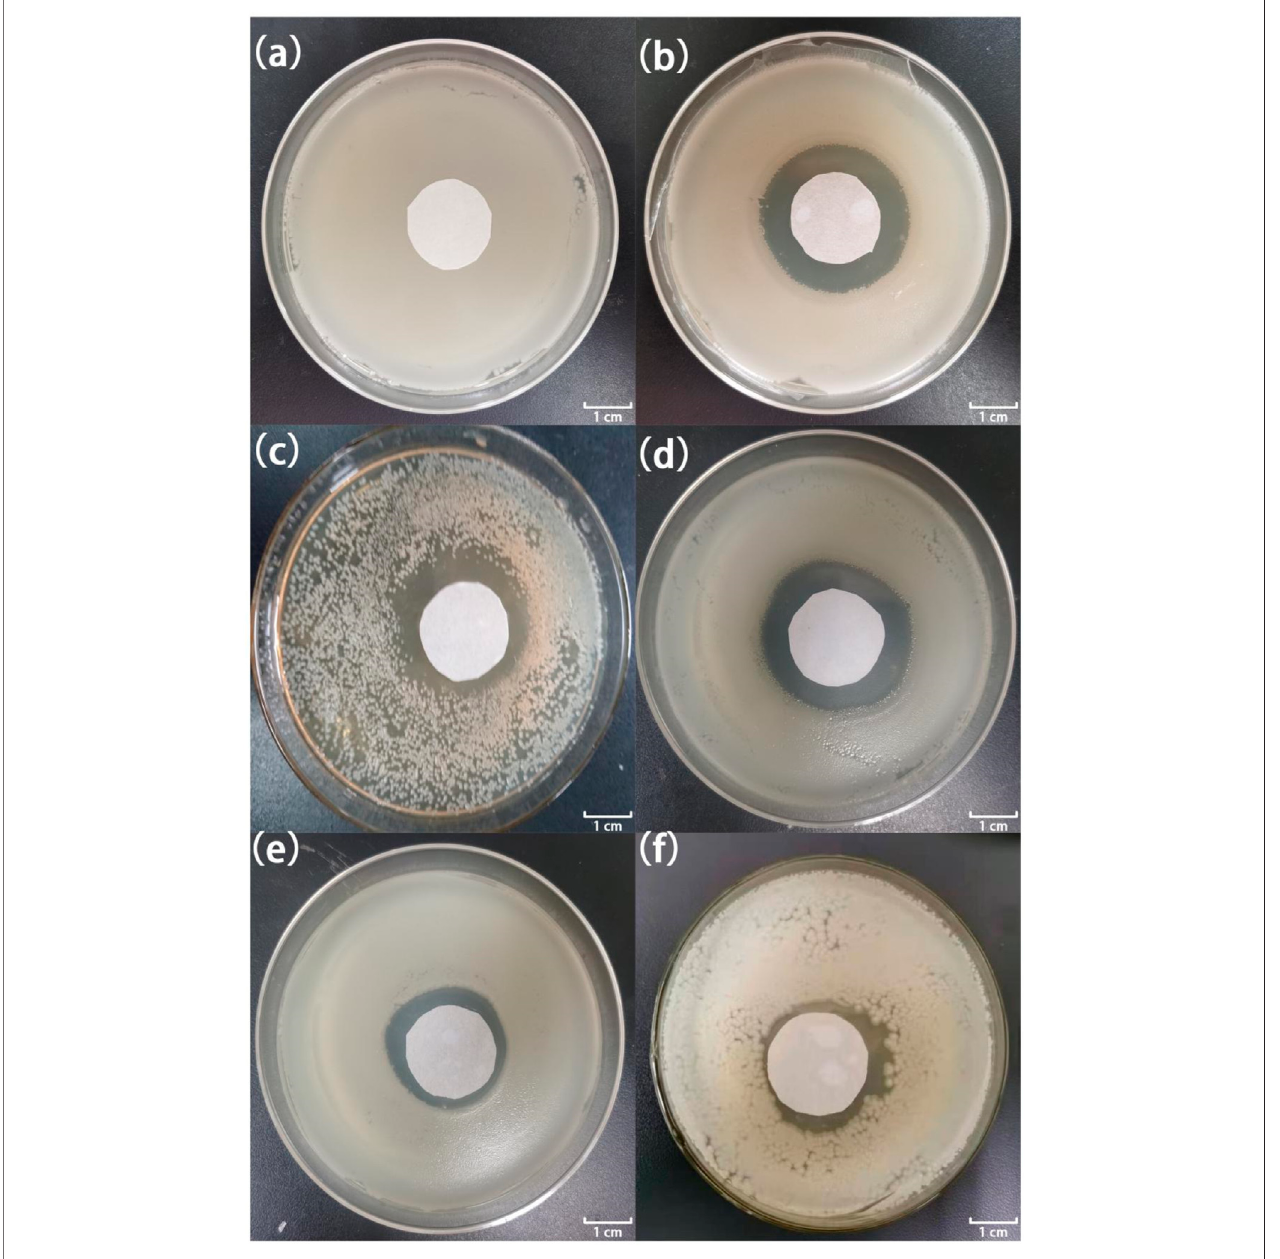
FIGURE 8 | Images of inhibition zones for different samples against S. aureus . (A) 0.0 μ g; (B) 20.0 μ g gentamycin; (C) 5.0 μ g LY@ZnO; (D) 20.0 μ g LY@ZnO; (E) 20.0 μ g LY; and (F) 20.0 μ g ZnO.